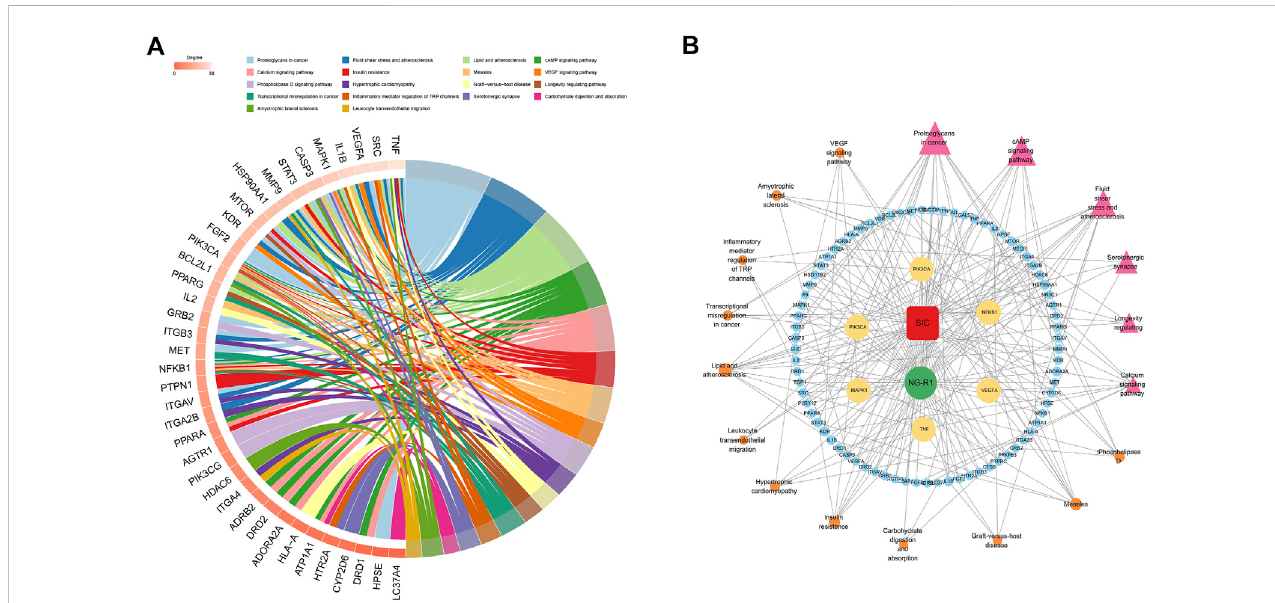
FIGURE 5 KEGG pathway and target-pathway network diagram construction. (A) The 51 targets ’ KEGG enrichment analysis. (B) Multidimensional network diagram of the fi rst 18 KEGG pathways ’ common targets and information.